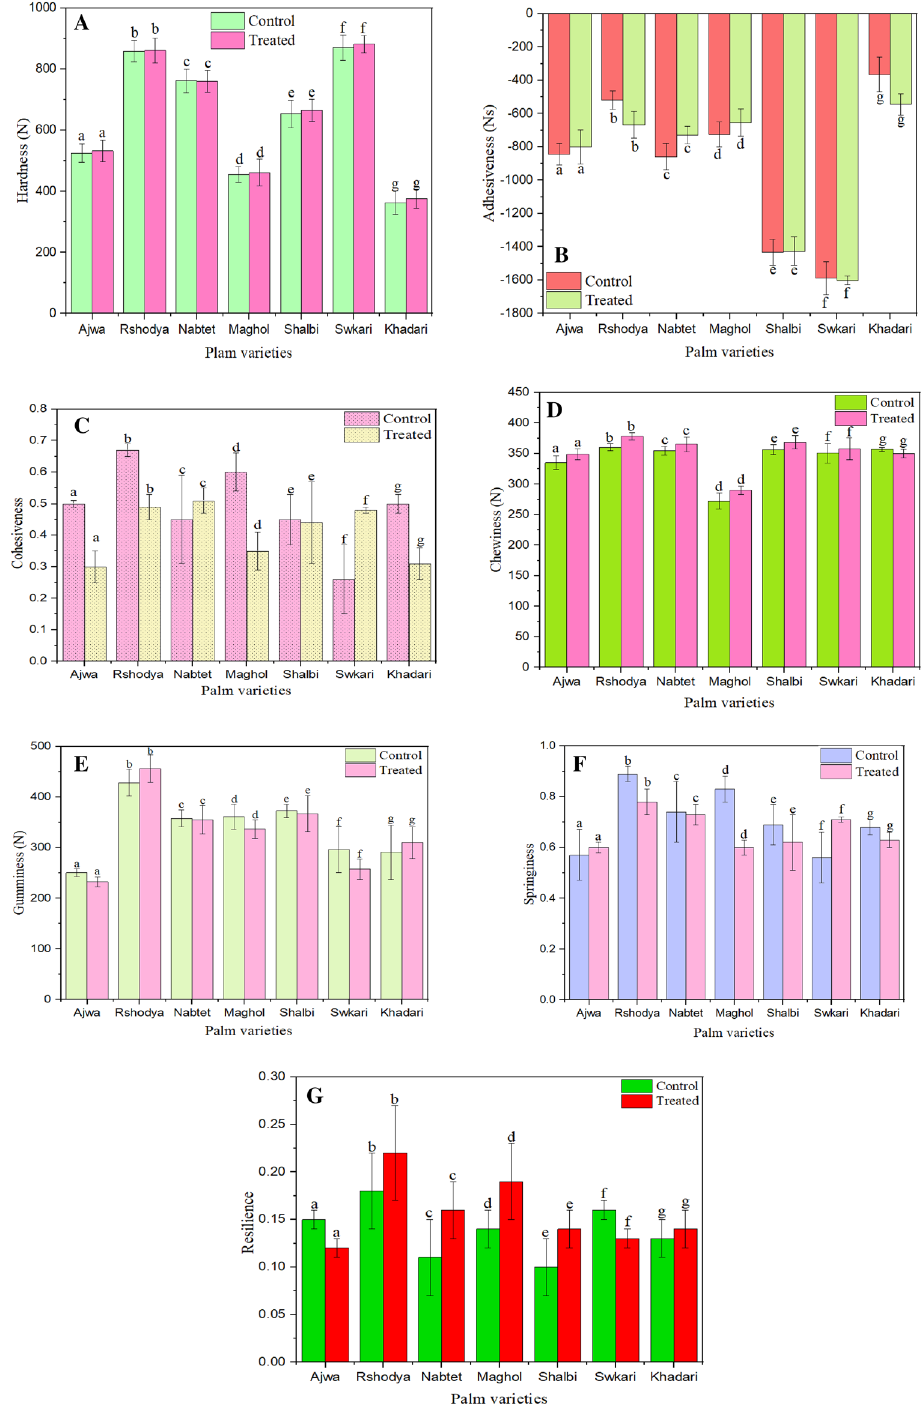
Figure 6. The influence of SDBD on texture of palm dates ( A ) Hardness P value = 0.06, ( B ) Adhesiveness P value = 0.75, ( C ) Cohesiveness P value = 0.06, ( D ) chewiness P value = 0.07, ( E ) Gumminess P value = 0.69, ( F ) Springiness P value = 0.24, ( G ) Resilience P value =